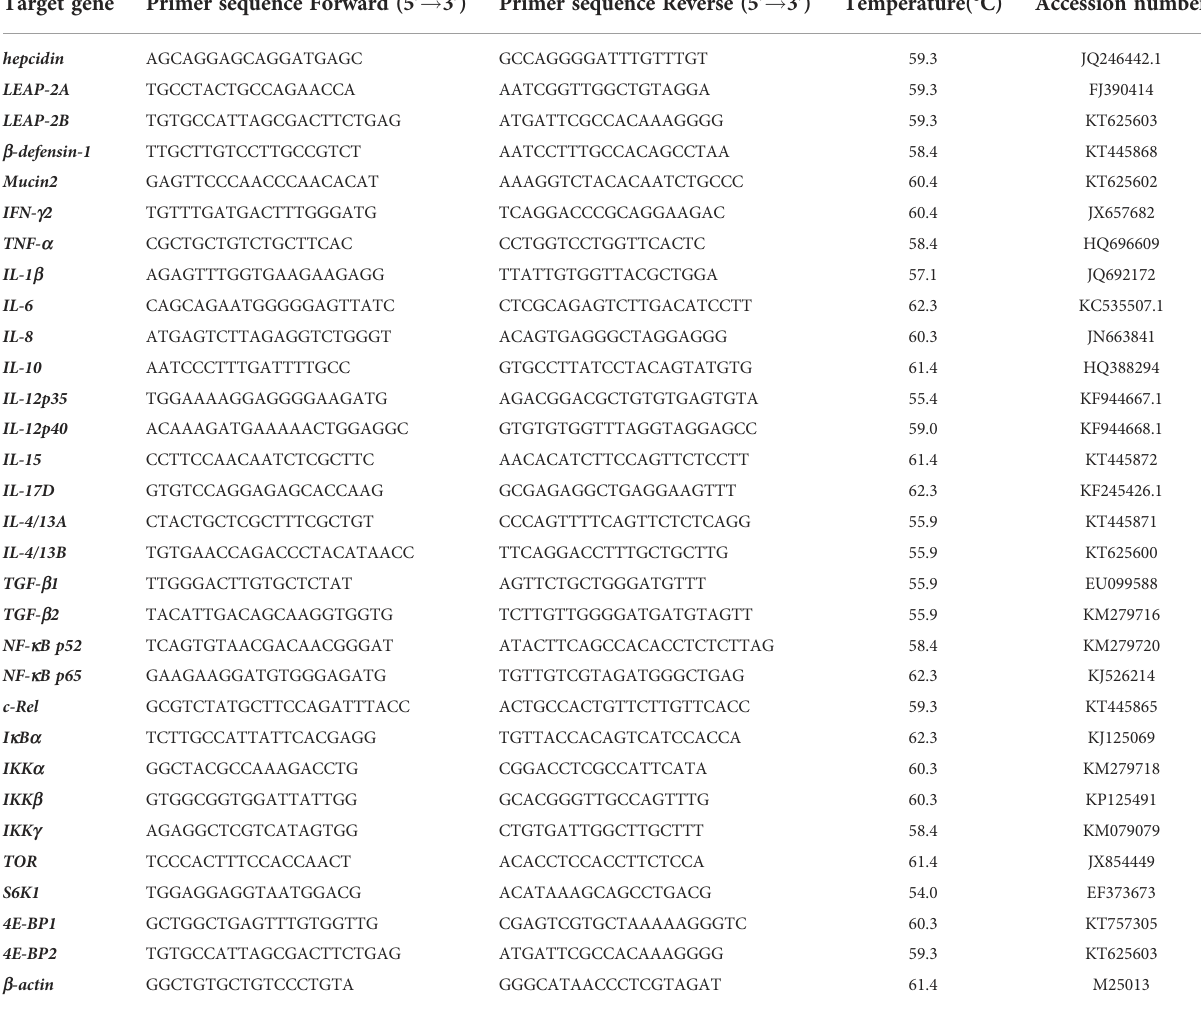
TABLE 1 Characteristics of different expression genes related to immune